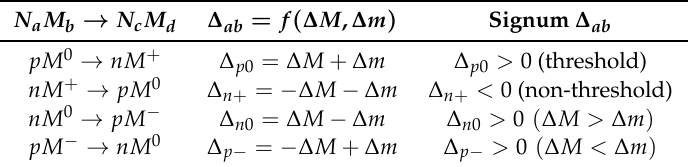
Table 4. The threshold parameters ∆ ab